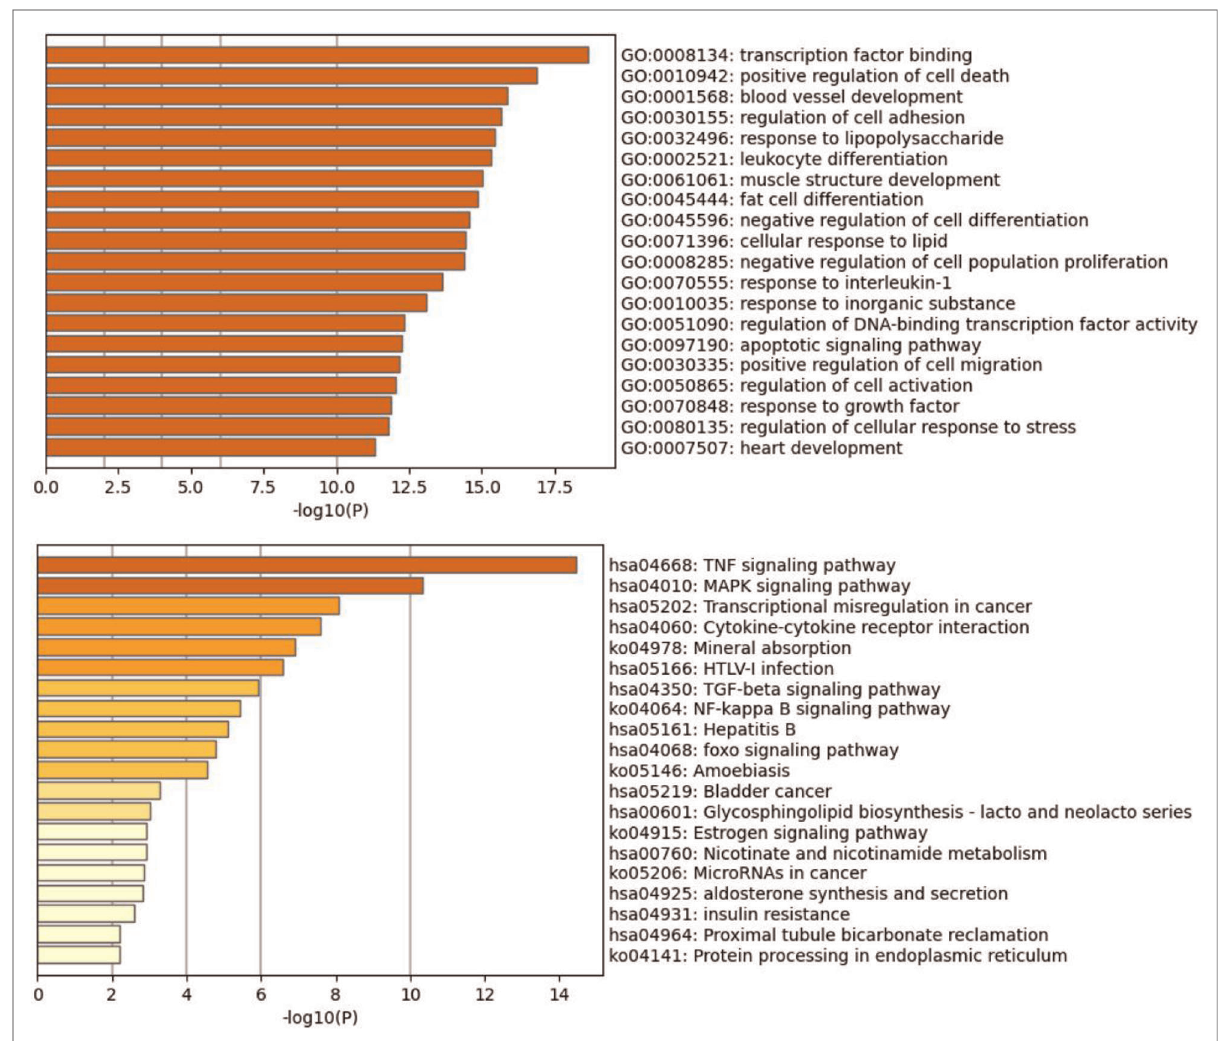
FIGURE 8 Bar graph of the top 20 GO and KEGG pathways (http://www.genome.jp/kegg/) across input brown module genes, colored by p-values.